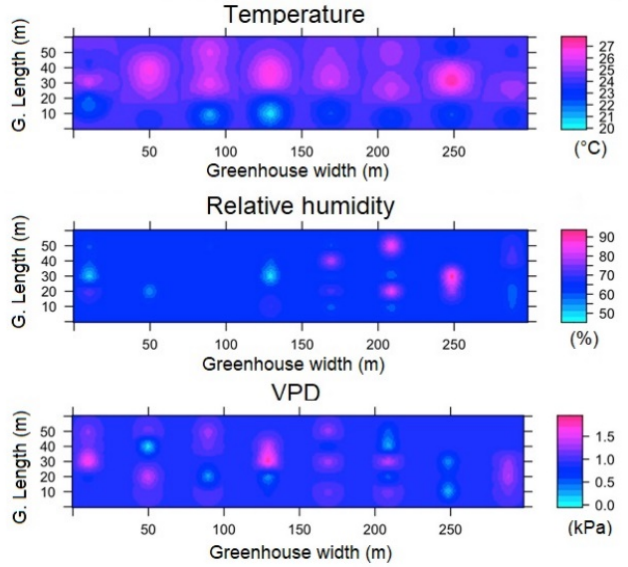
Figure 11. Spatial distribution predicted by kriging, for temperature, relative humidity and VPD in SG and for ESRL 1.